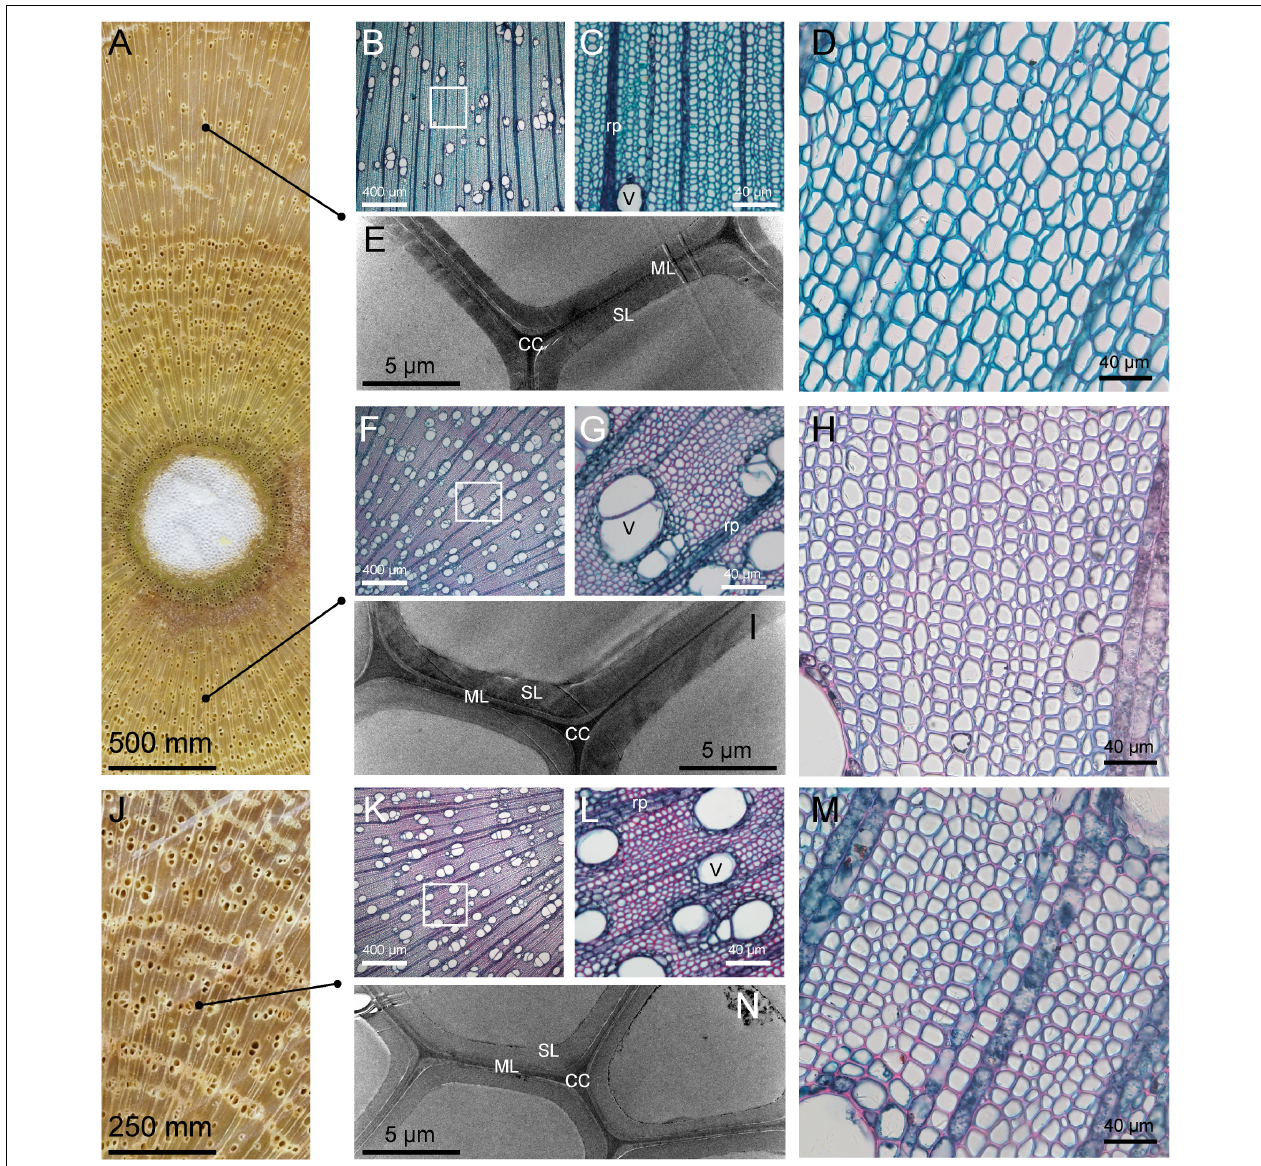
FIGURE 1 | Microstructure and ultrastructure of tension wood (TW), opposite wood (OW), and normal wood (NW). The tissue sections were stained with safranine and fast green. (A) Transverse TW and OW. (B–D) Light microscopy cross sections of TW. (E) Transmission electron microscopy illustrating TW; (F–H) light microscopy cross sections of OW. (I) Transmission electron microscopy illustrating OW; (J) transverse NW. (K–M) Light microscopy cross sections of NW. (N) Transmission electron microscopy illustrating of NW. rp, ray parenchyma; SL, secondary wall layer; ML, middle lamella; CC, cell corner; V,